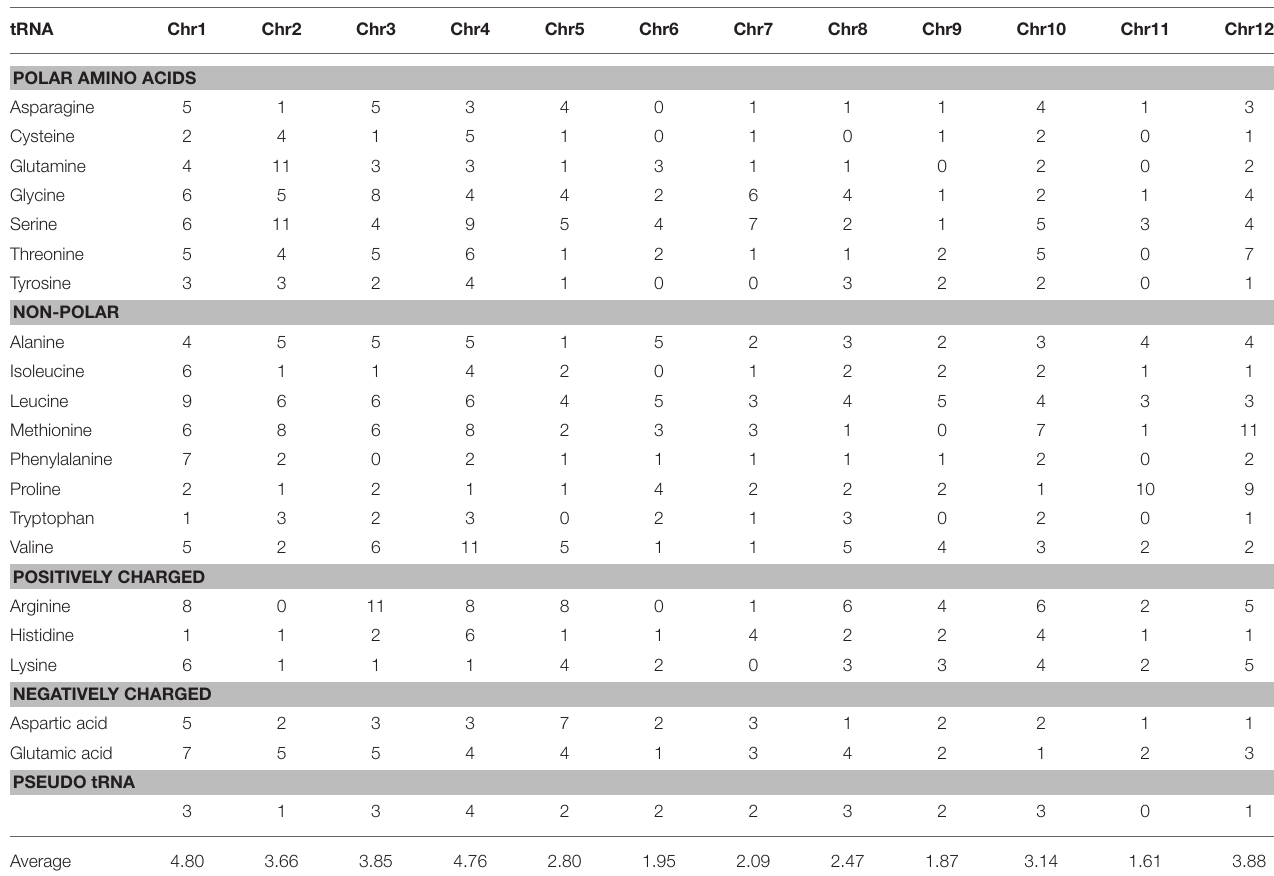
TABLE 2 | Chromosomal distribution of different tRNA in O. sativa . tRNA Chr1 Chr2 Chr3 Chr4 Chr5 Chr6 Chr12 POLAR AMINO ACIDS Asparagine